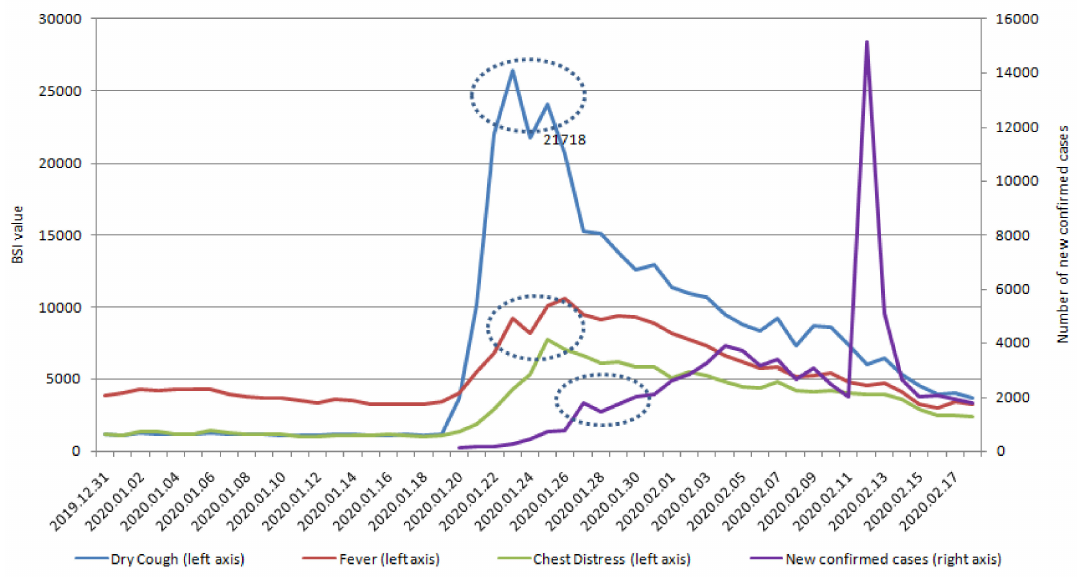
Figure 4. New confirmed COVID-19 cases and lag days of dry cough, fever, and chest distress.